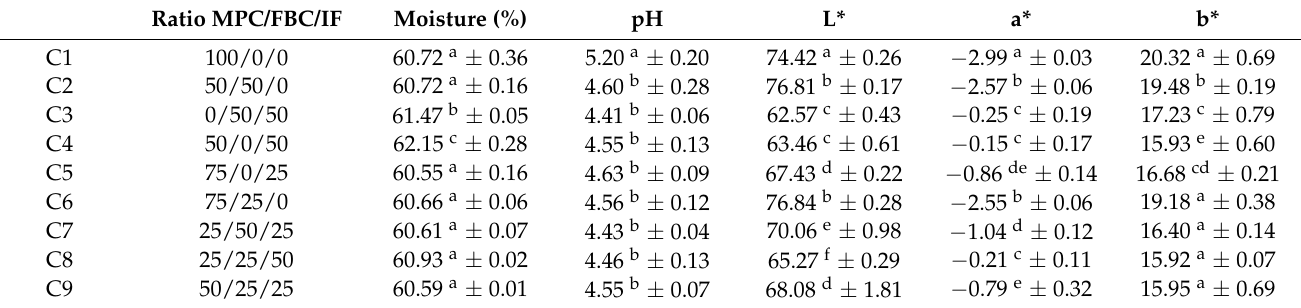
Table 3. Physicochemical characterisation of the spreadable cheese analogues. Values show means ± standard deviations, n = 36 for colour parameters and n = 18 for pH and moisture